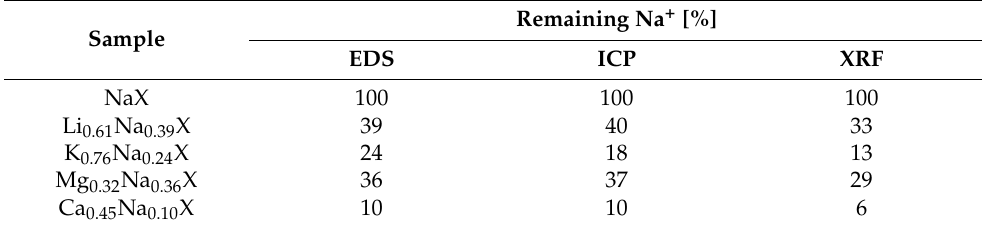
Table 1. The sodium content of cation exchanged